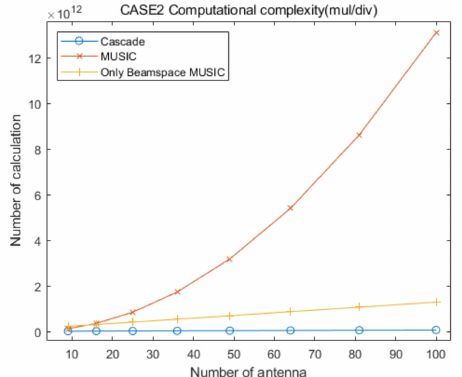
Figure 22. Curves for comparing addition / subtraction computational complexities of the proposed cascade algorithm, the general MUSIC algorithm, and the only Beamspace MUSIC algorithm, versus the number of antenna elements, for CASE 1.